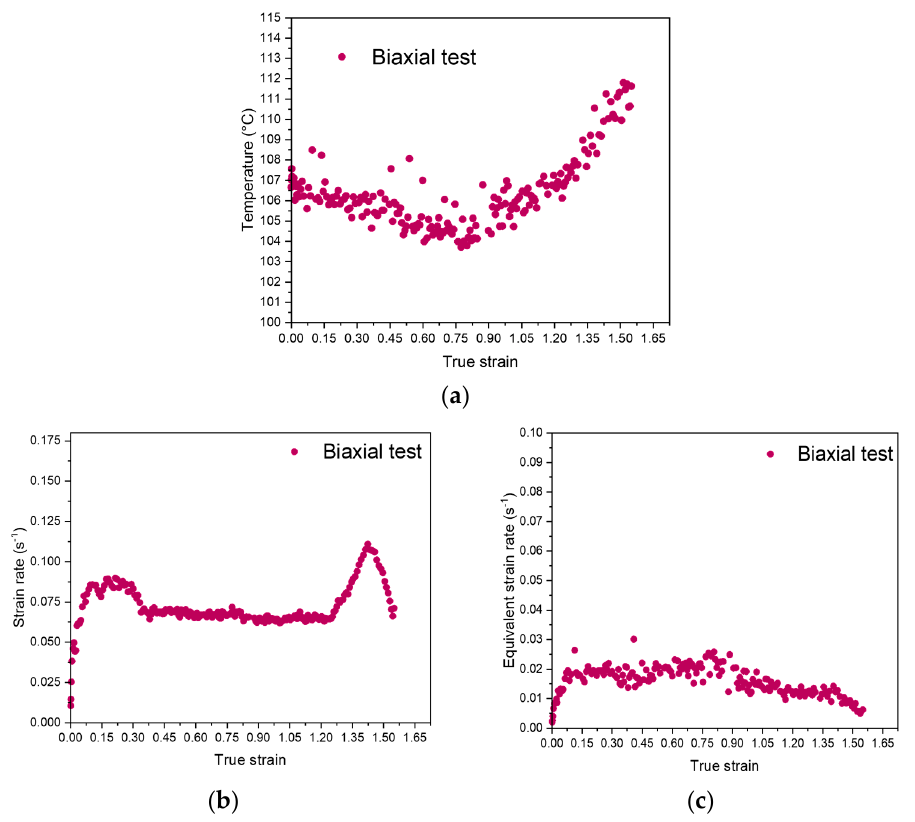
Figure 2. Evolution of ( a ) the temperature, ( b ) the strain rate and ( c ) the equivalent strain rate at a reference temperature of 100 °C, in equilibrated biaxial conditions.